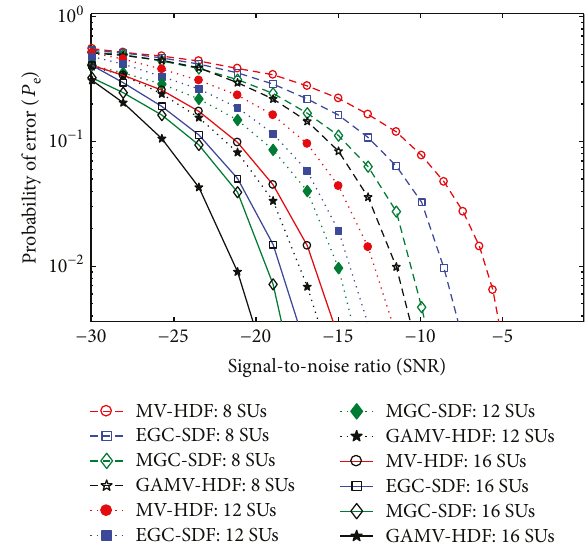
Figure 8: The probability of detection versus signal-to-noise ratio at di ff erent ratios of cooperative SUs with MUs having low SNR compared with NSUs.